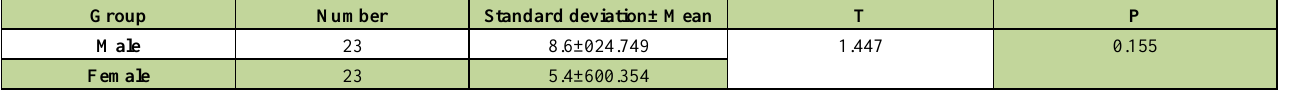
Table 9. Comparison of mean difference of index plaque index of toothpaste between two